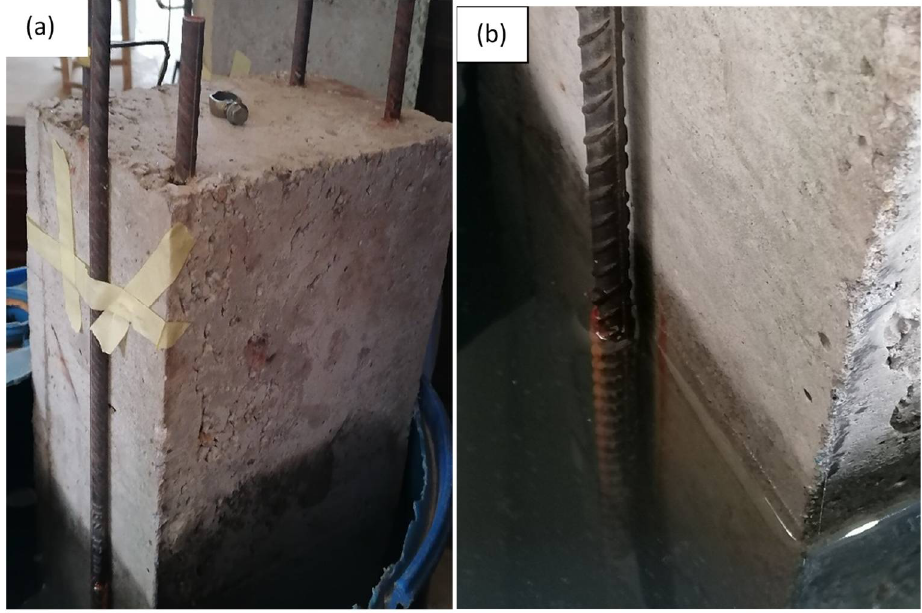
Figure 12. Evidence of corrosion on beams: ( a ) At early stage; ( b ) at maturity. Table 3. Steel reinforcement sample weight and mass loss.